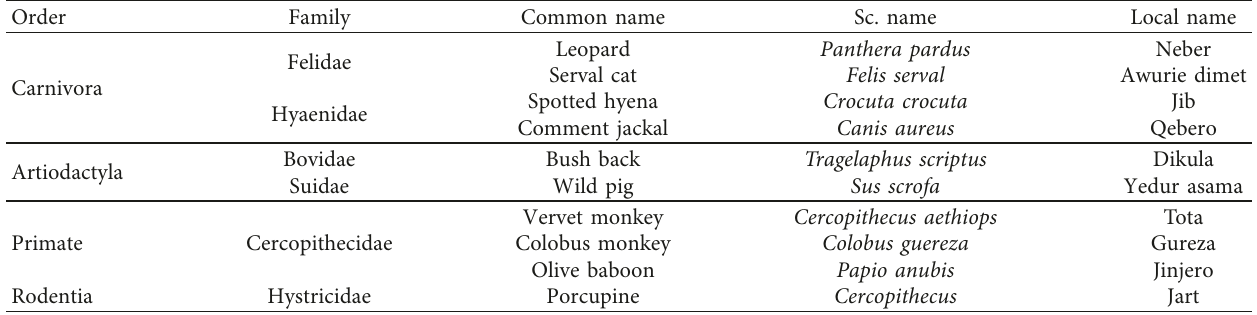
Table 1: Mammalian species identified in Tiski Waterfall in Awi Zone, Ethiopia.